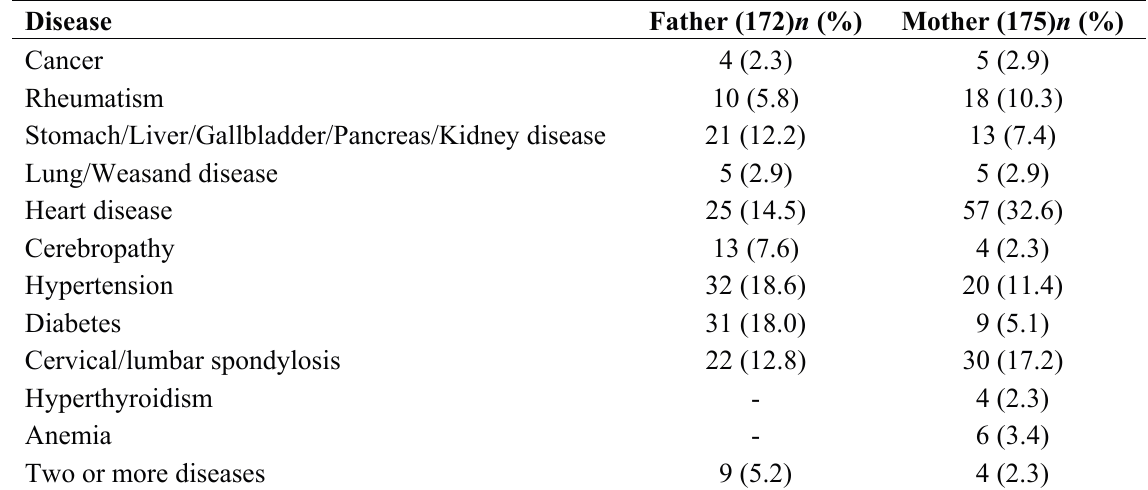
Table 1. Detailed information of parental physical